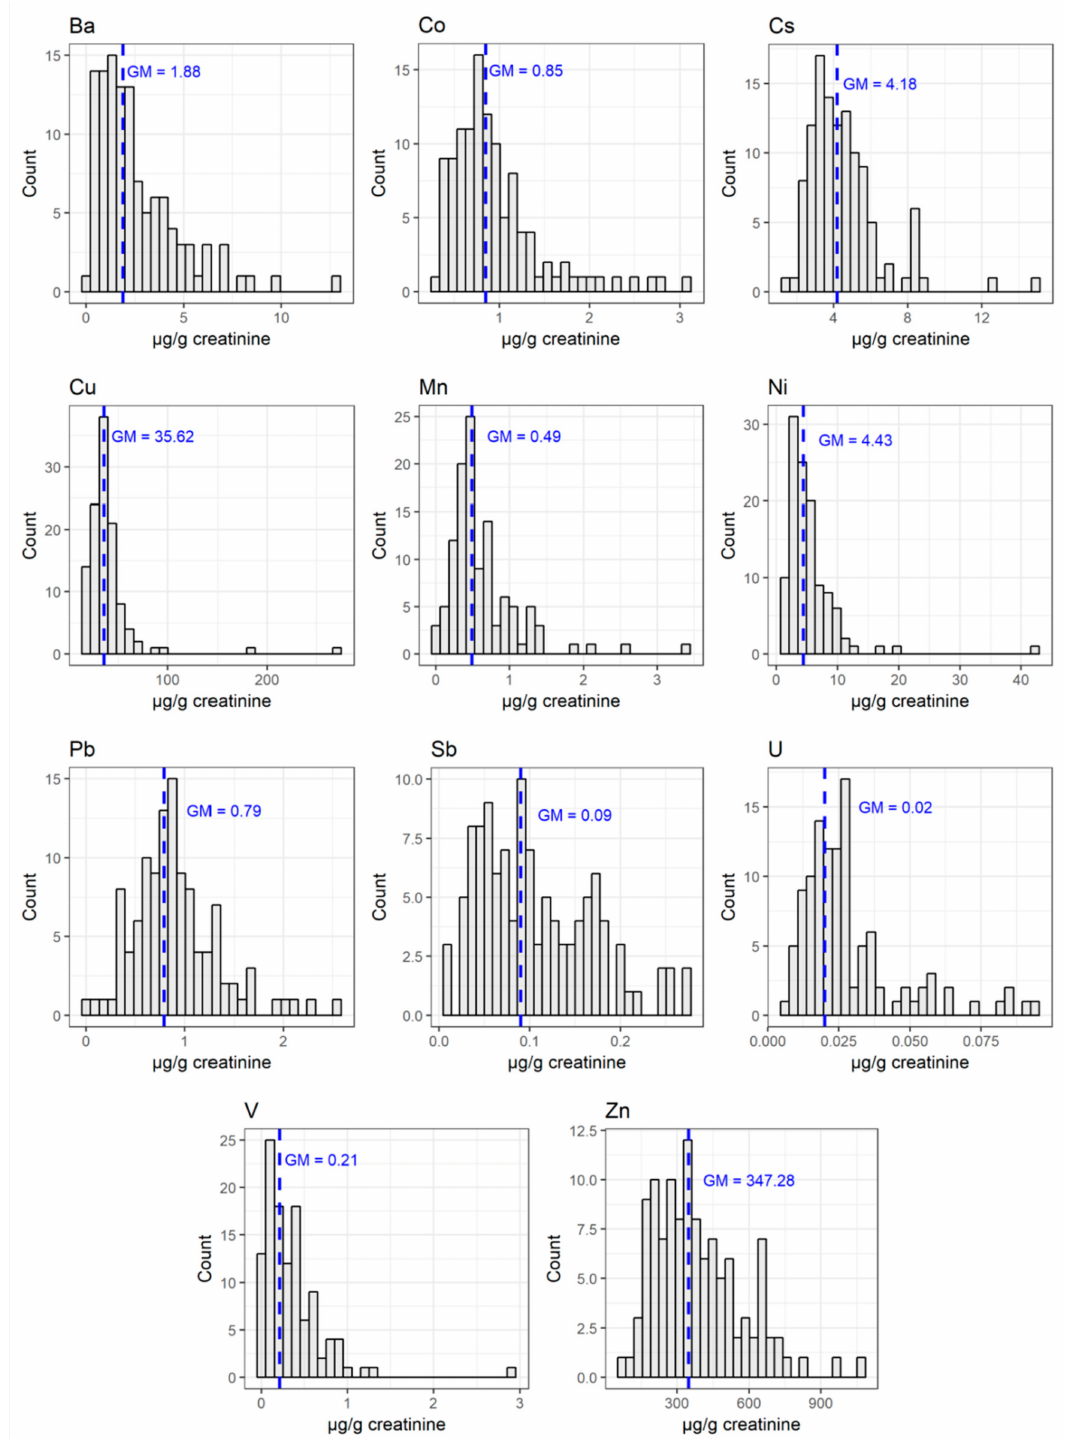
Figure 1. Histograms for some investigated elements (Ba, Co, Cs, Cu, Mn, Ni, Pb, Sb, V, Zn, and U). GM: geometric